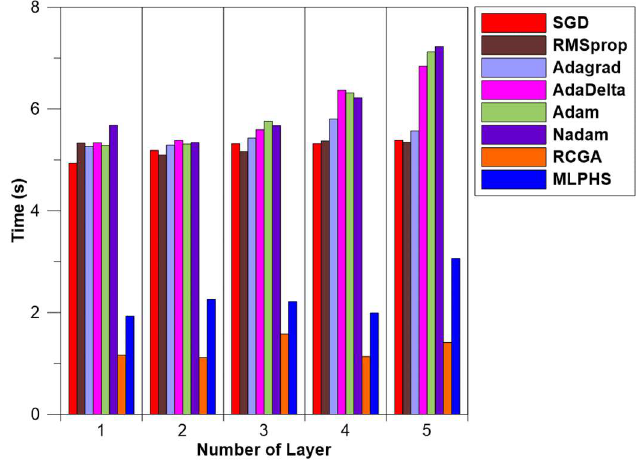
Figure 9. Comparison of average time required for each optimizer according to the number of hidden layers.